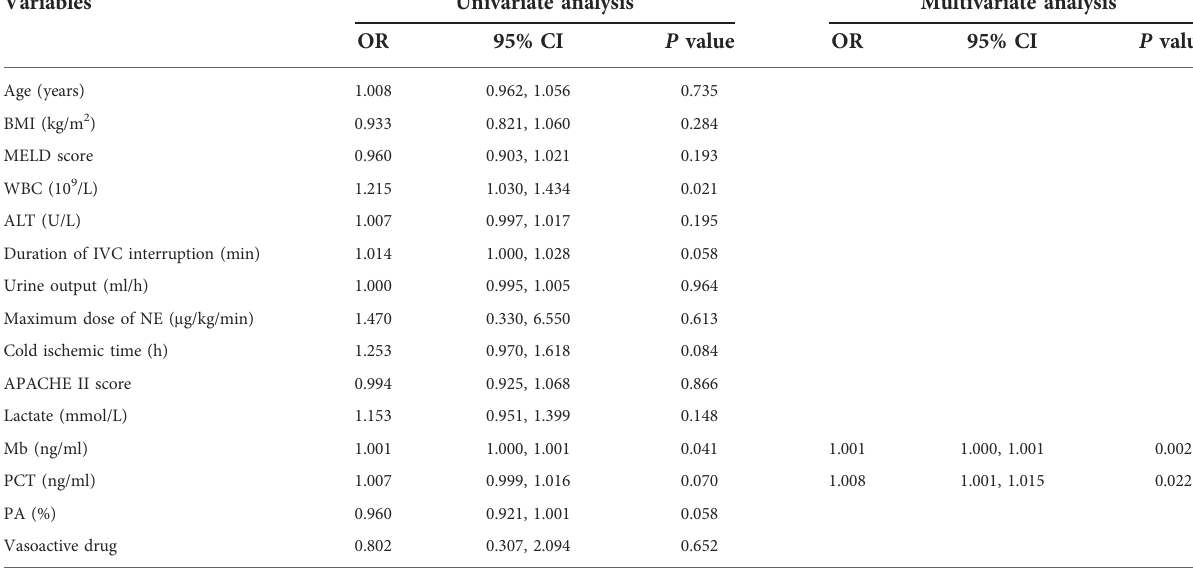
TABLE 3 Univariate and multivariate logistic analyses of risk factors for EAD.